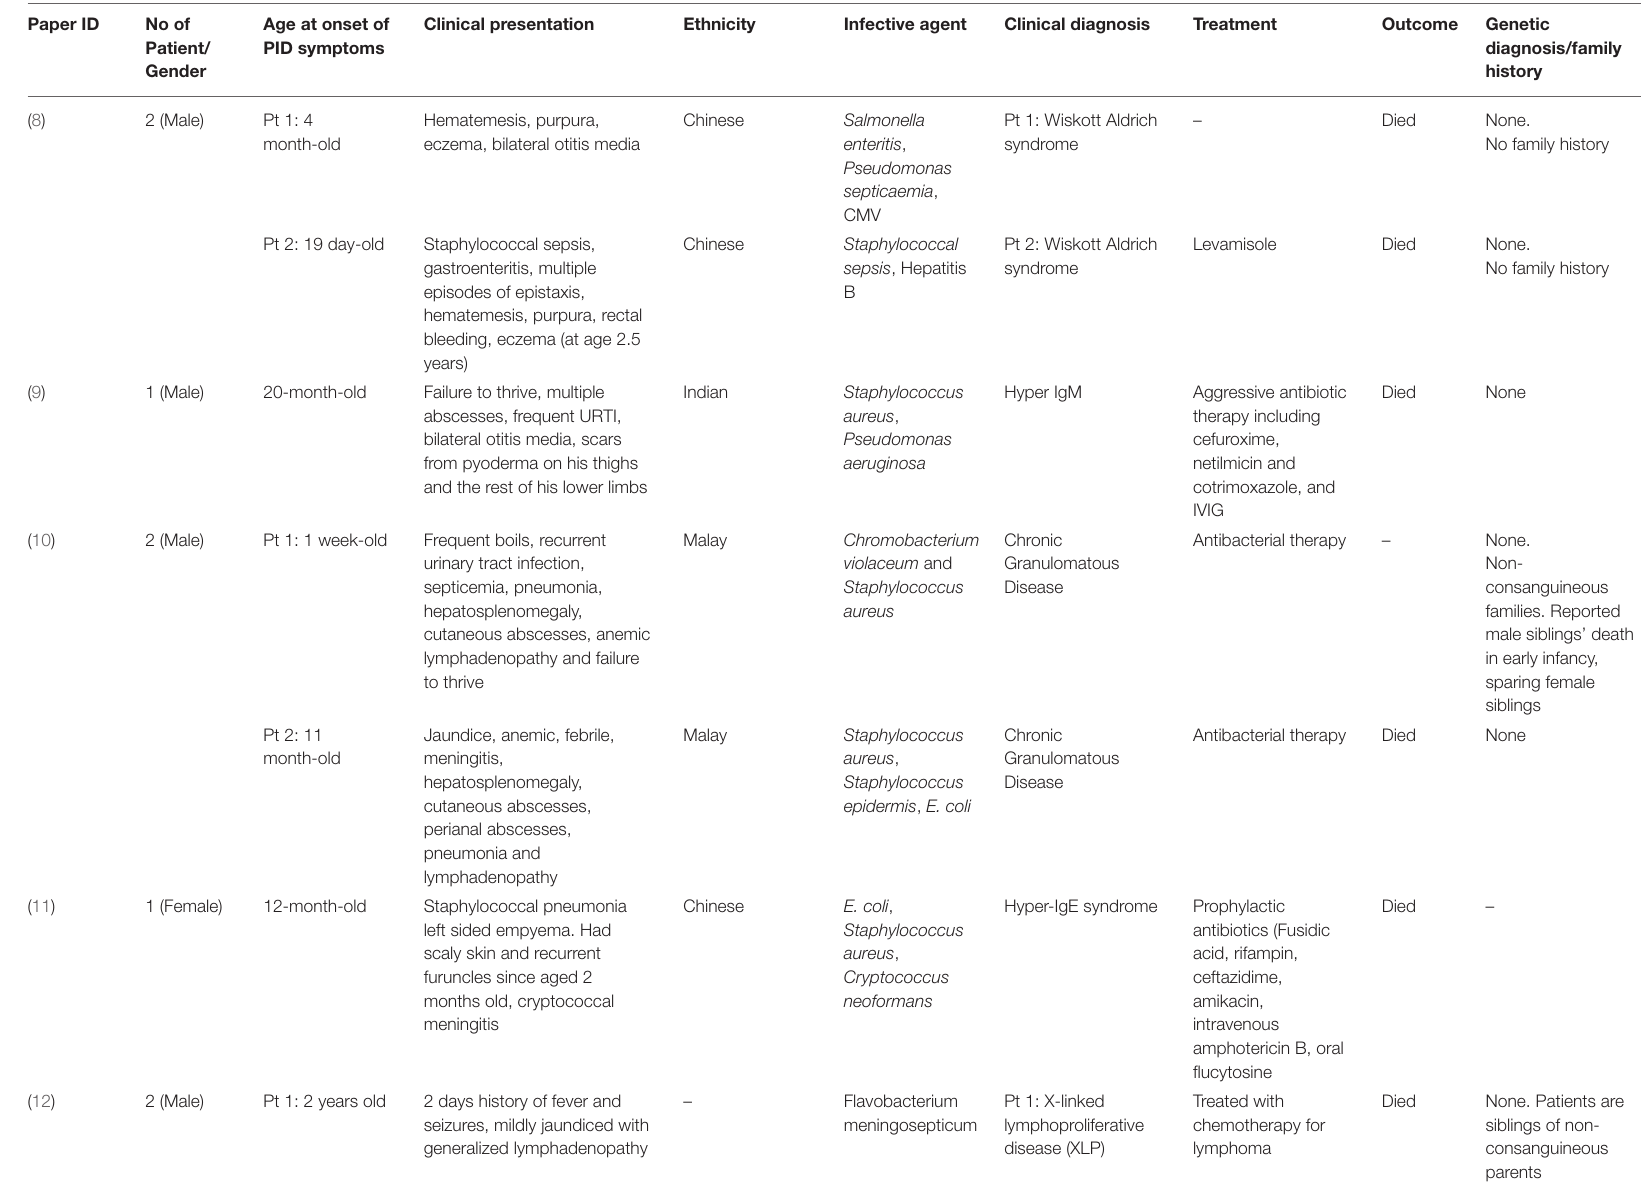
TABLE 1 | Primary Immunodeficiency Diseases Cases Reported in